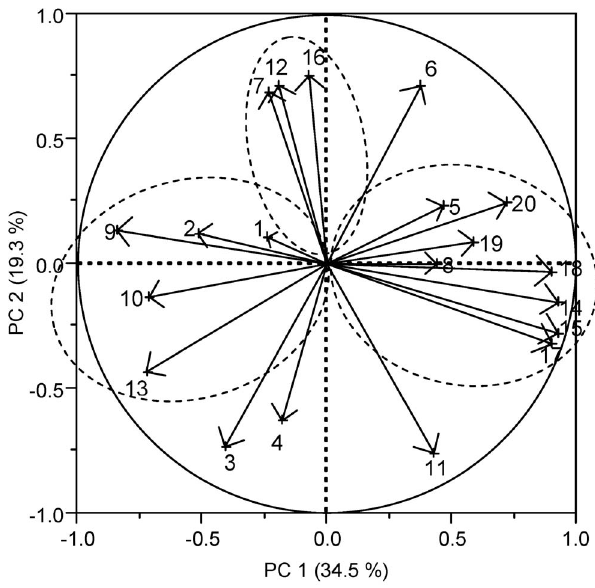
Figure 5. Principle component analysis (PCA). Loading plot of the first two principle components (PC1 and PC2) was build based on the following variables in cecum: gene copy numbers of bacterial groups; SCFA, histology score and mucosal IL-1 b concentration. The loading plot of the first two principle components (PC1 and PC2) depicts the correlations between the different variables. Numbers represent individual variables as follows: 1, Bacteroides group; 2, Lactobacillus group; 3, Bifidobacterium spp.; 4, Enterobacteriaceae family; 5, Clostrid- ium cluster I; 6, Clostridium cluster IV; 7, Clostridium cluster XIVa; 8, Butyryl-CoA transferase gene; 9, Butyrate-kinase gene; 10, Clostridium cluster XI; 11, Clostridium difficile toxin B; 12, total SCFA; 13, acetate; 14, propionate; 15, iso-butyrate; 16, butyrate; 17, iso-valerate; 18, valerate; 19, cecal IL-1 b concentration; 20, histology score of cecum.